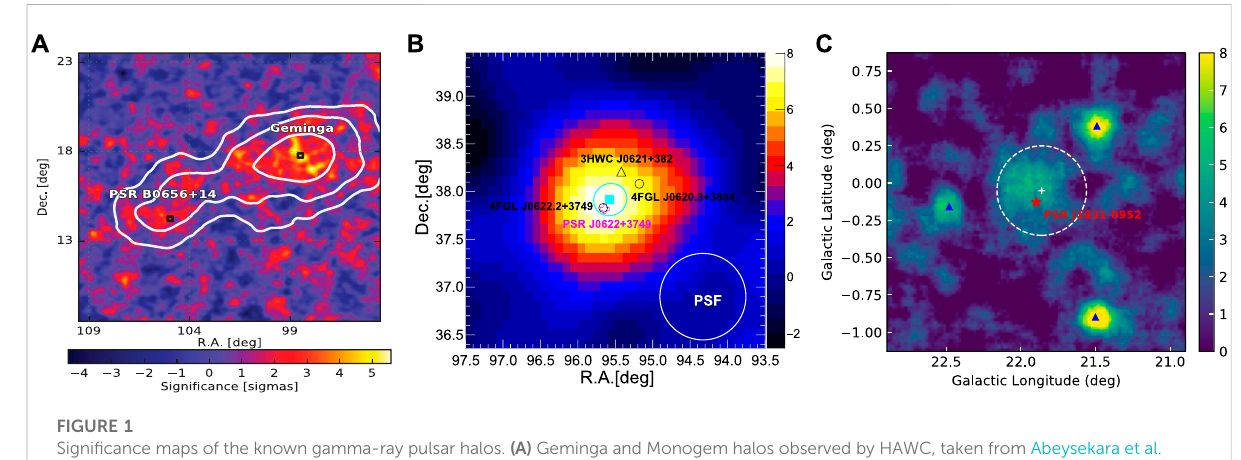
FIGURE 1 Signi fi cance maps of the known gamma-ray pulsar halos. (A) Geminga and Monogem halos observed by HAWC, taken from Abeysekara et al. (2017) with permission from Science. Copyright © 2017, AAAS. (B) LHAASO J0621 + 3755 observed by LHAASO-KM2A, taken from Aharonian et al. (2021)with permissionfrom Physical Review Letters. Copyright ©2021, APS. (C) Signi fi cance map ofHESS J1831 − 098given bytheH.E.S.S. Galactic plane survey (Abdalla et al., 2018) with the integration radius of 0.1 ° , taken from Fang et al. (2022). One may refer to the original papers for the meaning of the marks in the fi